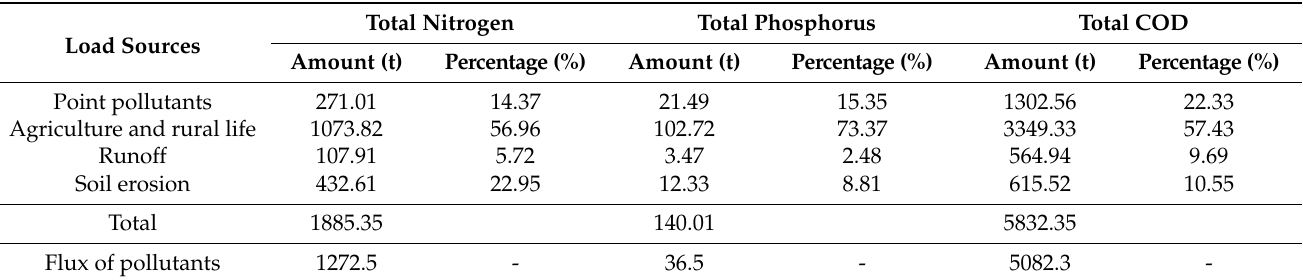
Table 5. The load of total pollutants entering Baiyangdian lake.